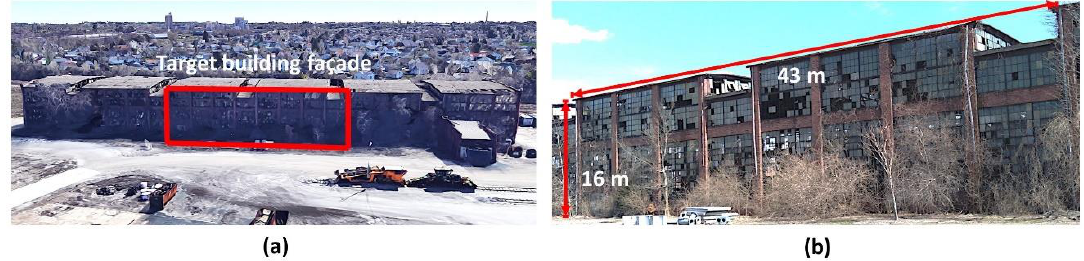
Figure 4. Experimental validation using a building having severe façade damage: ( a ) 3D view of the building (courtesy of Google 3D Maps) [31] and ( b ) Façade test region.